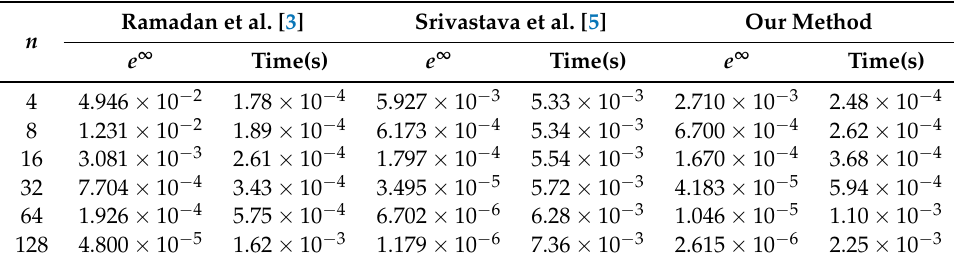
Table 3. Maximum errors and elapsed CPU times in Example